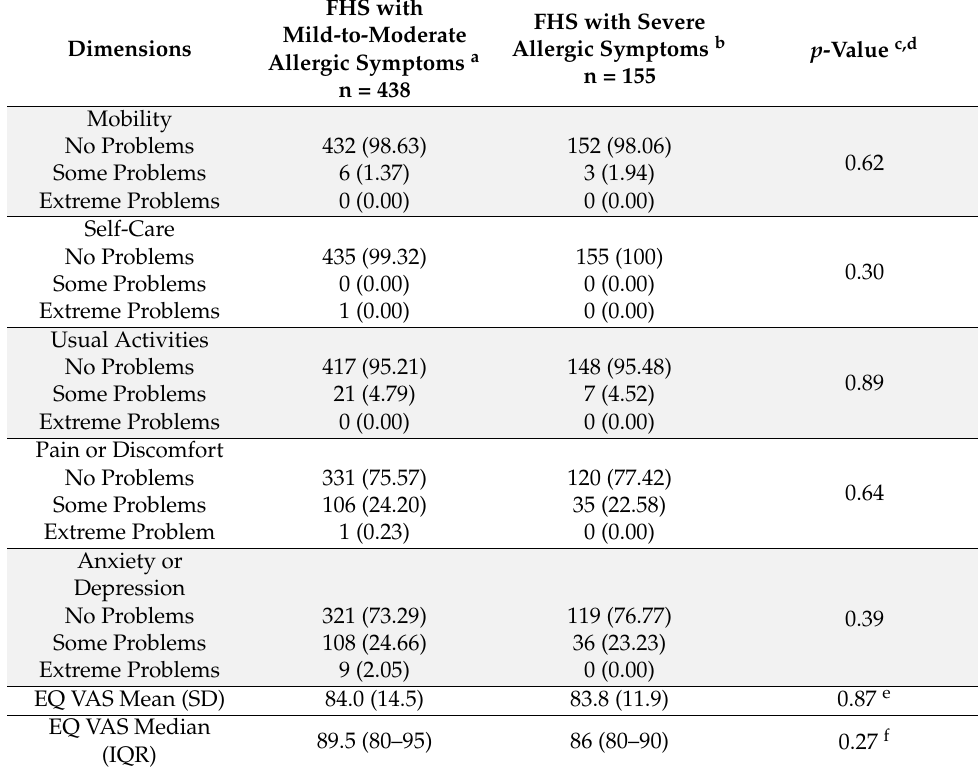
Table 3. Distribution of EQ-5D among adolescents with food hypersensitivity (FHS) in relation to mild/moderate a and severe b allergic